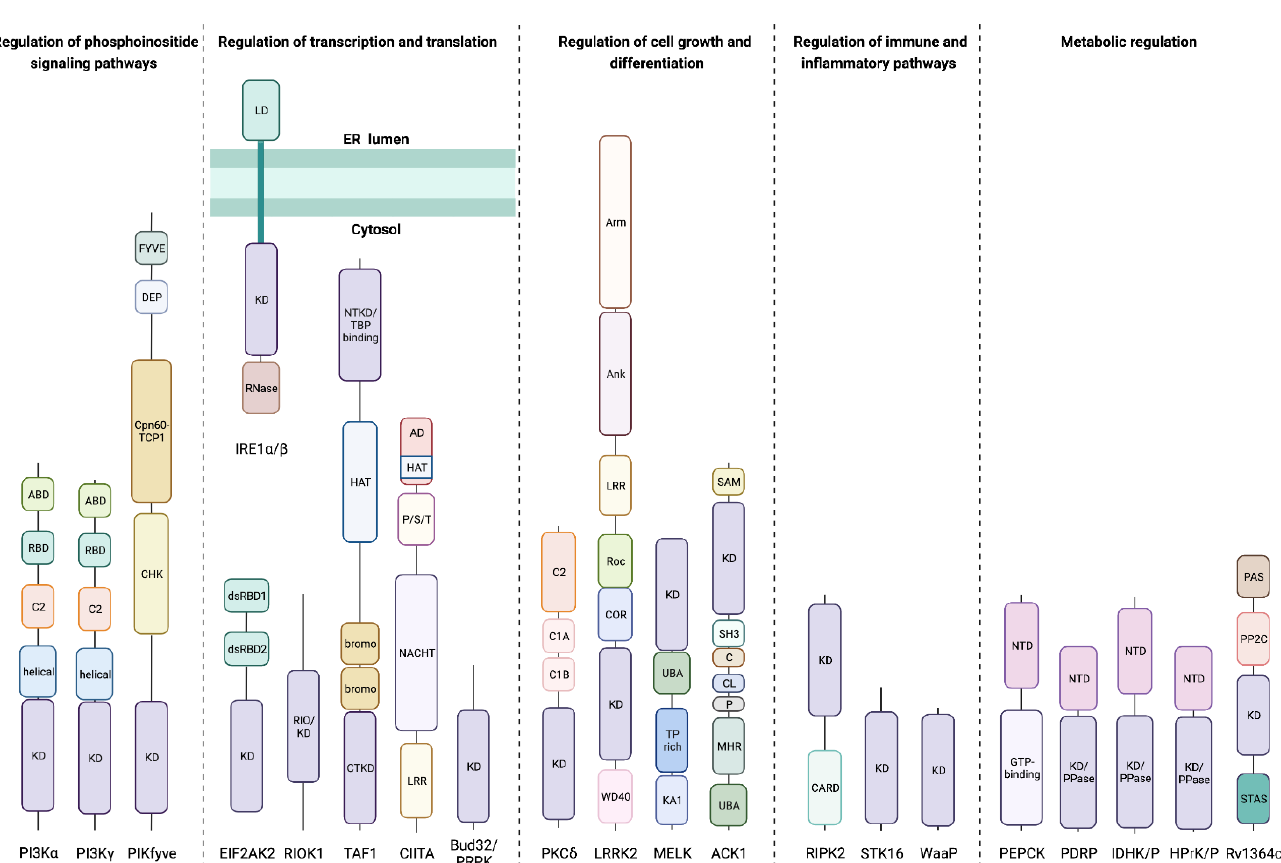
Figure 1. Domain architecture of bifunctional kinases. Representative structural domain schematic of 22 unique bifunctional kinases annotated in the UniProtKB database. Abbreviations denote the following: kinase domain (KD), Ras-binding domain (RBD), adaptor-binding domain